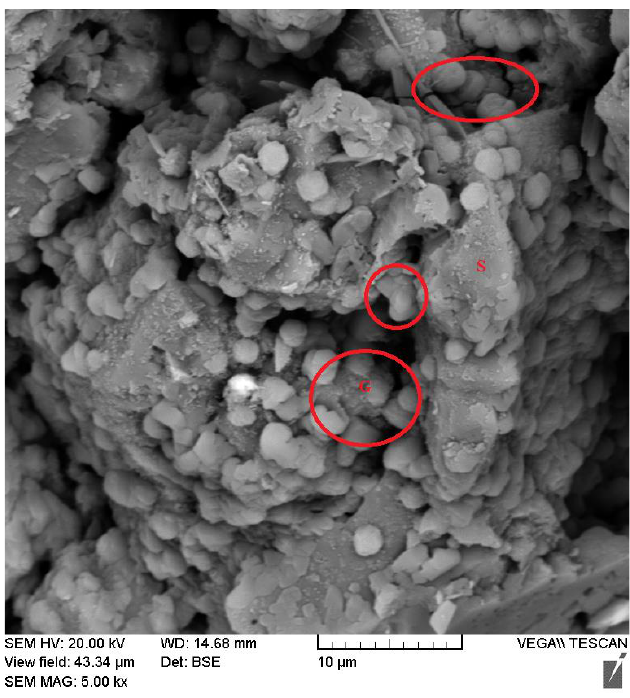
Figure 13. SEM images of FS70 geopolymer-treated sample G (Geopolymer), S (Soil).